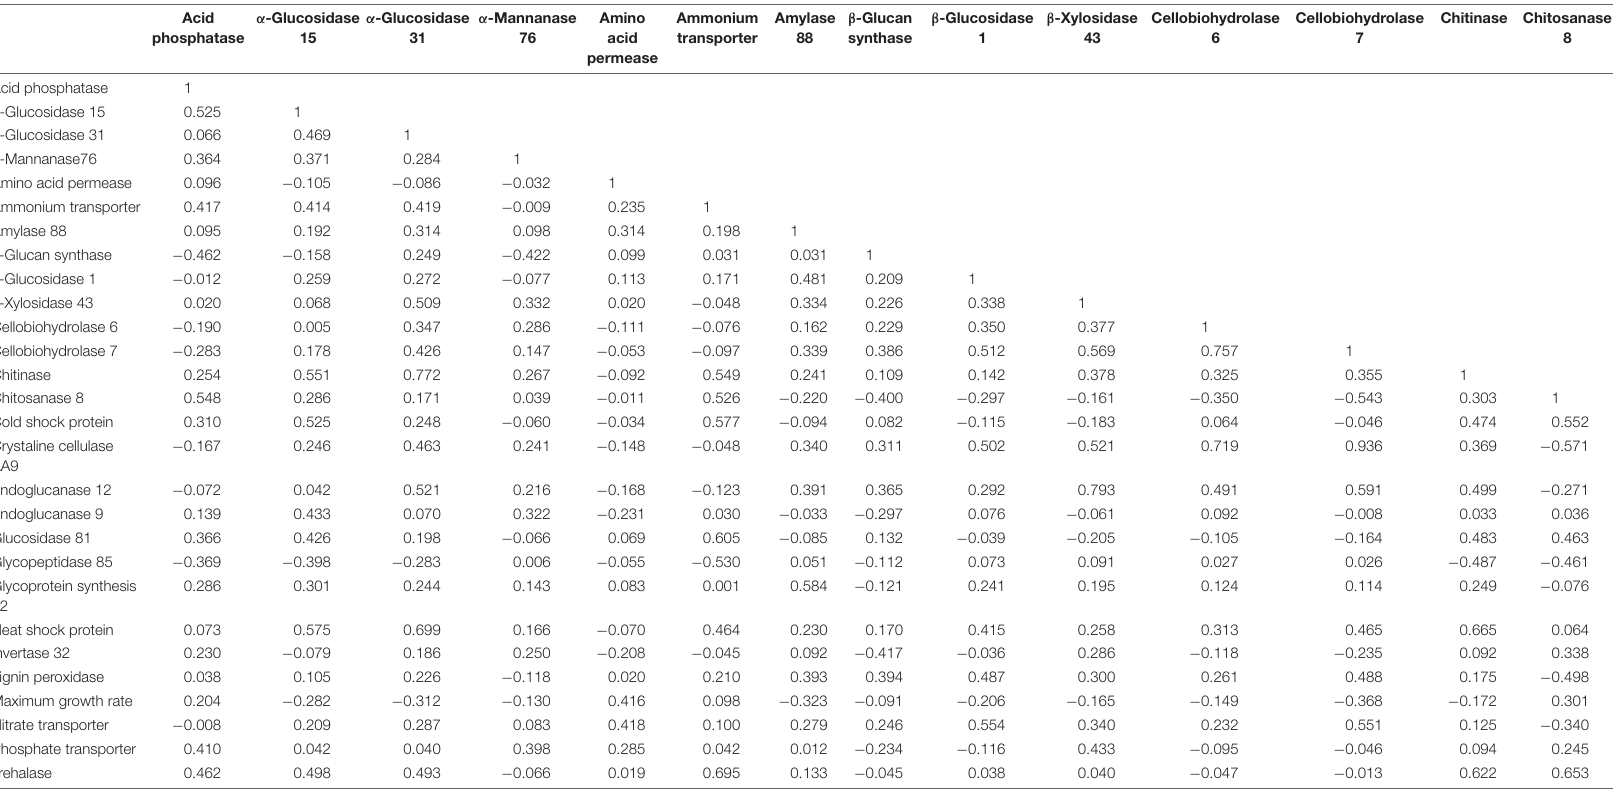
TABLE 3 | Phylogenetic independent contrast r coefficients for all fungal traits used for non-metric multidimensional scaling